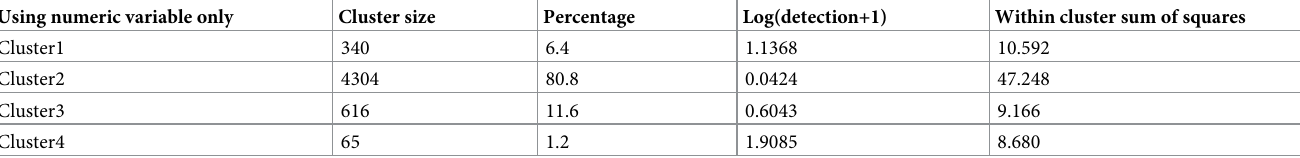
Table 6. Summary statistics using numerical variable only for detection data from Barrow Island between 2009 and 2015.